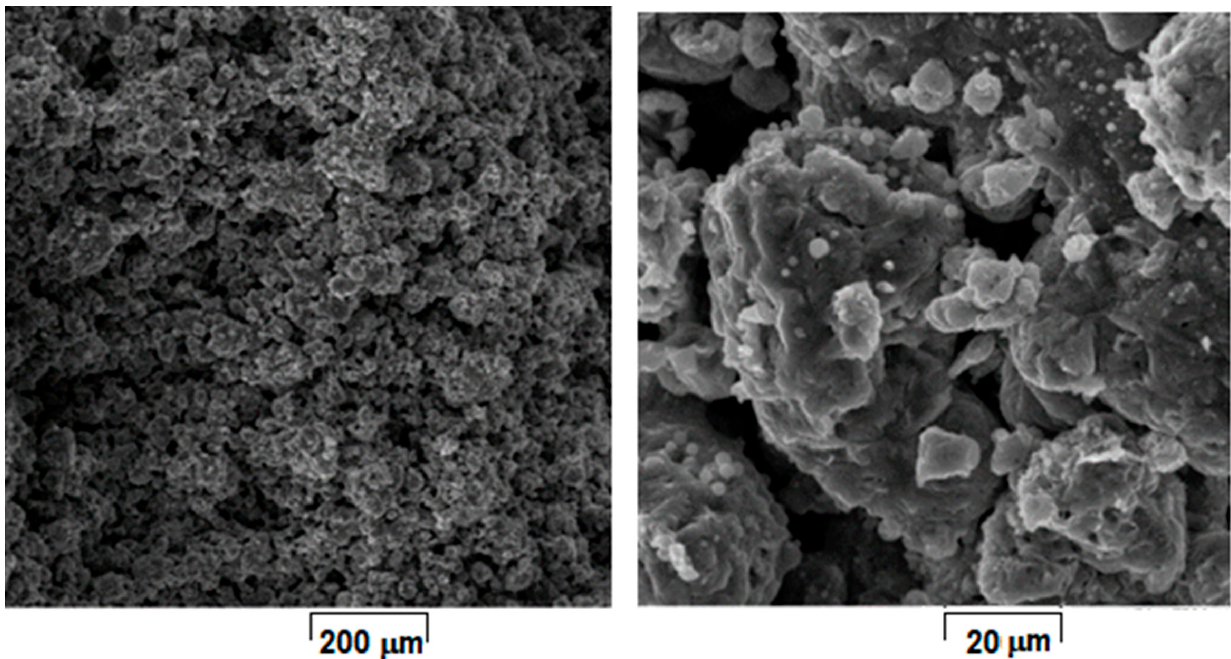
Figure 6. SEM-SE images of L-PBF sample obtained with laser power 200 W; scanning speed 700 mm/s; layer height 30 µ m applied parameters and calculated laser energy density 238 J/mm 3 .